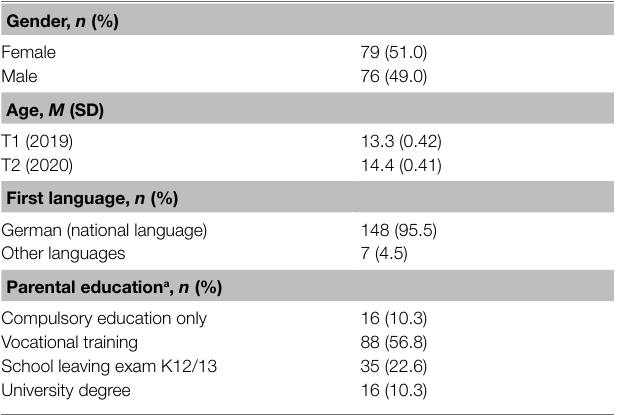
TABLE 1 | Demographic characteristics of the